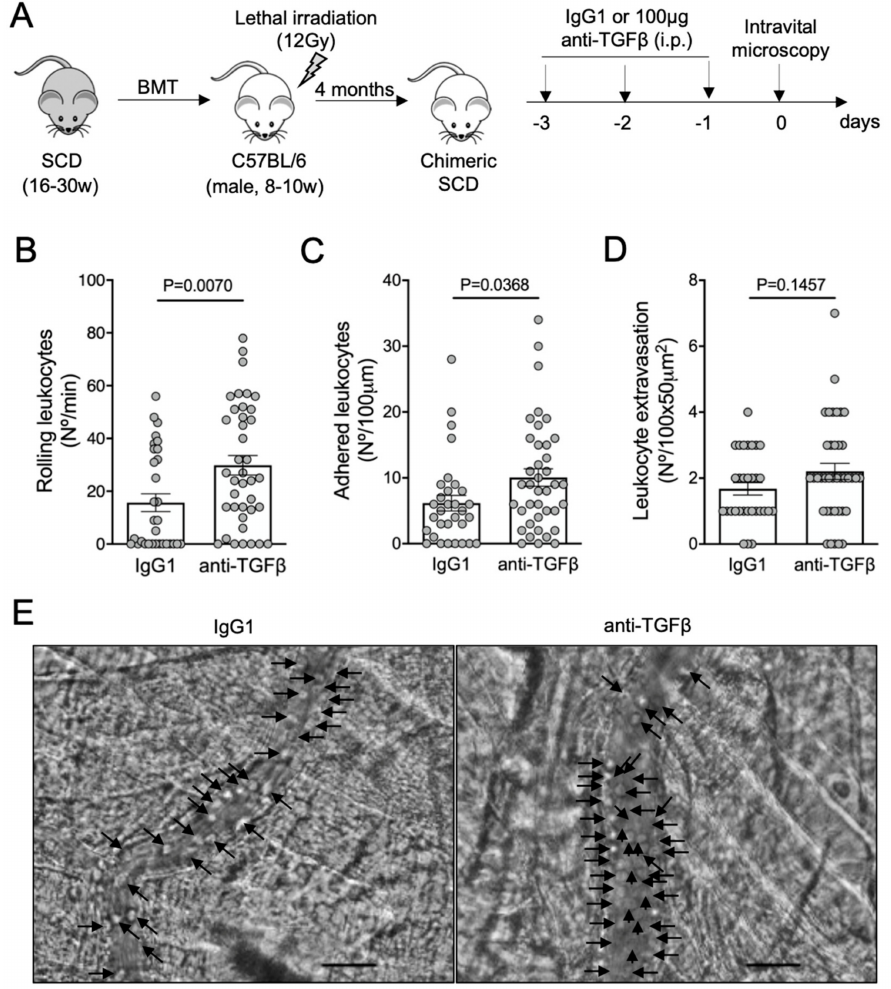
Figure 2. Vaso-occlusion in the microvasculature of SCD mice after neutralization of TGF- β : ( A ) experimental design. Chimeric SCD mice were generated by transplantation of bone marrow cells (BMT) from transgenic SCD mice into lethally irradiated (12Gy) C57BL/6 male mice. After complete bone marrow repopulation (4 months), animals were injected with anti-TGF- β antibody (100 µ g, i.p) or IgG1 isotype control for three consecutive days. On the fourth day, the microcirculation of the cremaster muscle was visualized by intravital microscopy; ( B ) number of rolling leukocytes (Nº/100 µ m/min); ( C ) number of leukocytes adhered to endothelium (Nº/100 µ m); ( D ) number of leukocytes extravasated to tissue (Nº/100 × 50 µ m 2 ). IgG1 group: N = 4 mice, 31 venules. Anti-TGF- β group: N = 5 mice, 39 venules. Student’s t -test for ( B , C ); Mann–Whitney test for ( D ); ( E ) representative images obtained during intravital microscopy (left: Video S3; right: Video S4). Arrows indicate leukocytes interacting with the endothelium (e.g., adhered or rolling). Scale bar = 20 µ